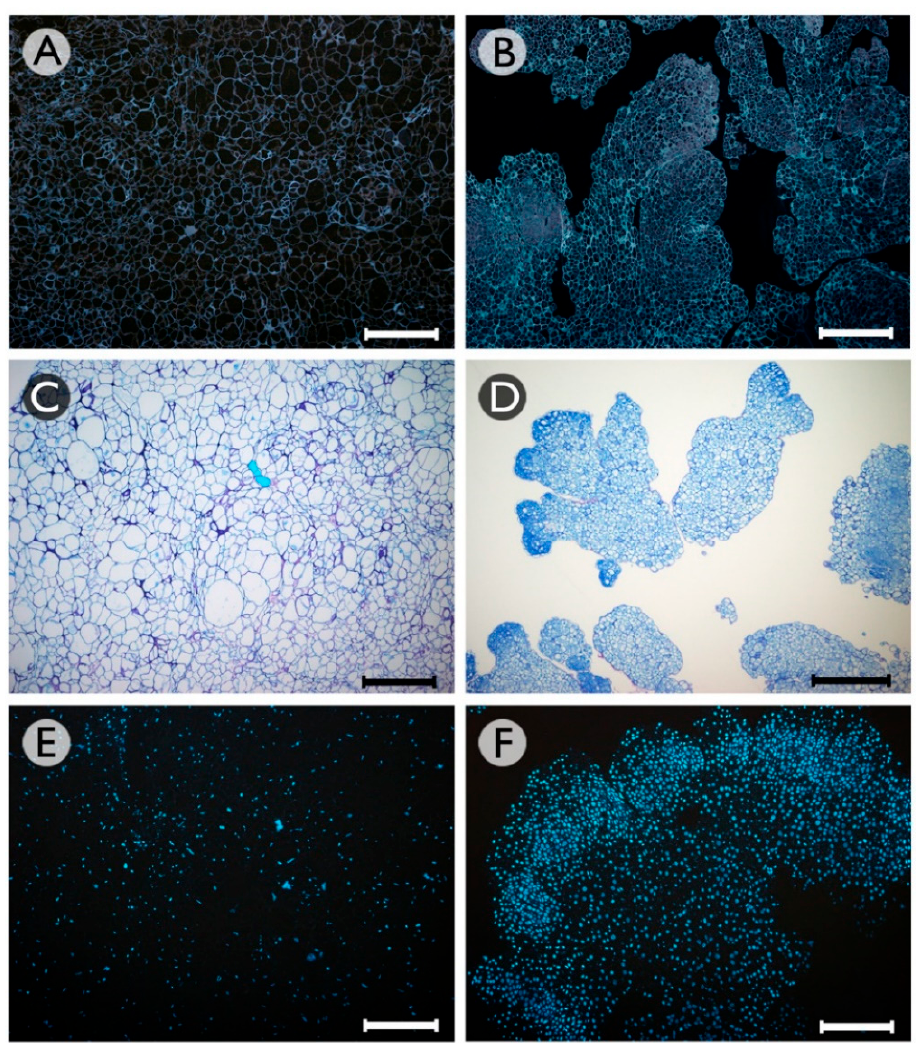
Figure 2. Histological analysis of non-embryogenic calli ( A , C , E ) and somatic embryo aggregates ( B , D , F ) formed from grapevine cv. Menc í a cotyledonary somatic embryos that were cultured in an induction medium without HDAC inhibitors or supplemented with 0.5 mM NaB. Sections were stained with calcofluor ( A , B ), toluidine blue ( C , D ), or DAPI ( E , F ). Bars: 200 μ m.